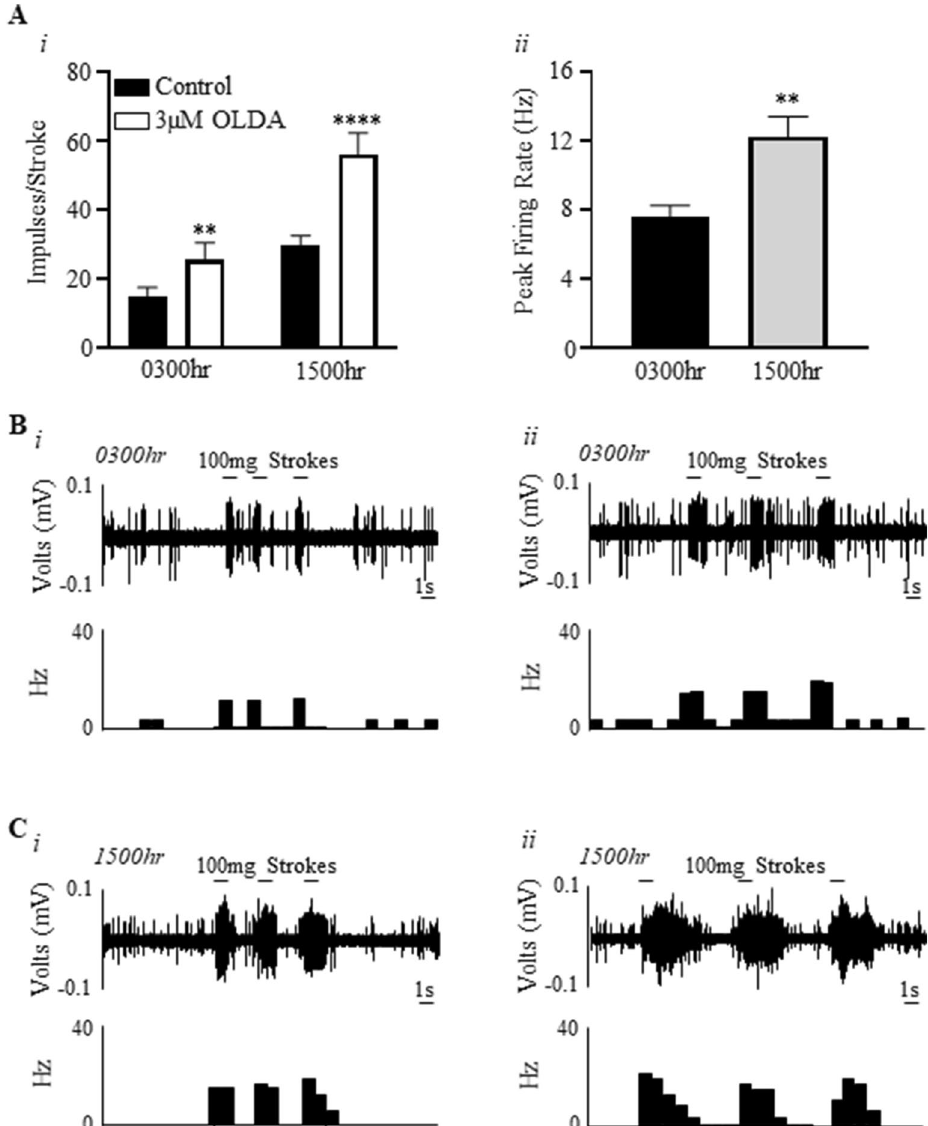
Figure 5. The response of mucosal afferents to N-oleoyl Dopamine is greater during the day compared to the night. ( Ai ) Mucosal afferent sensitivity to mucosal stroking (100 mg) before and after 3 μM N-Oleoyl Dopamine (OLDA) at 0300 h and 1500 h. ( Aii ) Direct activation of mucosal afferents by 3 μM OLDA at 0300 h and 1500 h. N = 6, n = 6. **P < 0.01, ****P < 0.0001. ( B ) An example of a raw trace of mucosal afferent responses to stroking in the ( i ) absence and ( ii ) presence of 3 μM OLDA at 0300 h. ( C ) An example of a raw trace of mucosal afferent responses to stroking in the ( i ) absence and ( ii ) presence of 3 μM OLDA at 1500